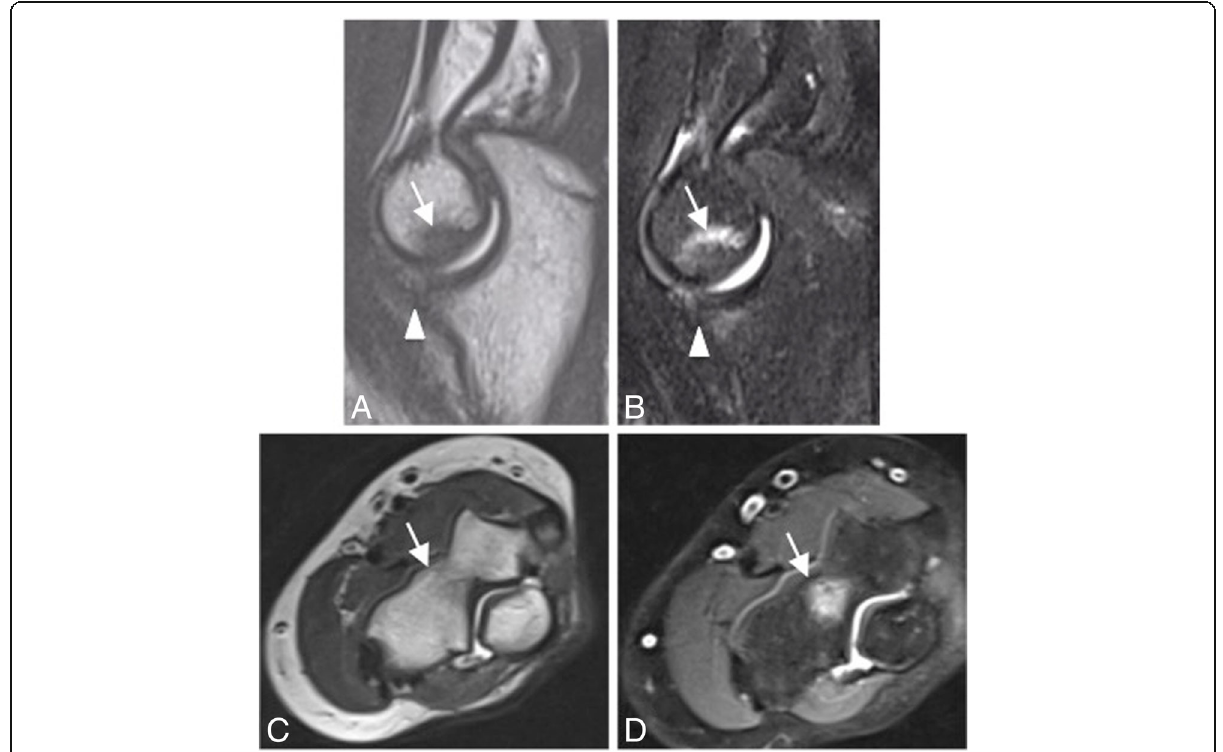
Fig. 12 Sagittal T2-weighted MRI ( a ), sagittal FS PD-weighted MRI ( b ), axial T2-weighted MRI ( c ), and axial FS PD-weighted MRI ( d ) demonstrate an osteochondral lesion of the trochlea (white arrows), and a non-displaced fracture of the coronoid process (white arrowheads)